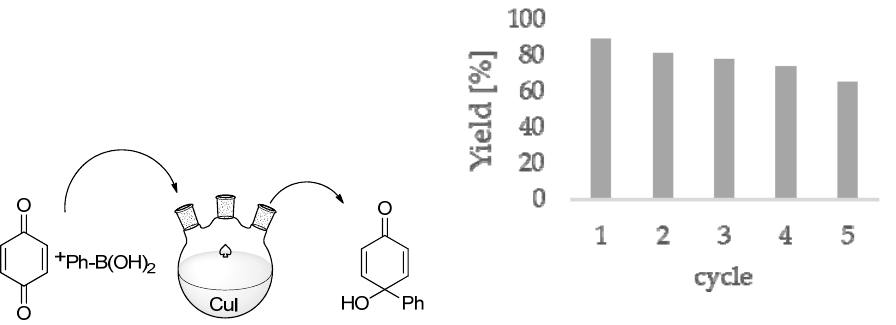
Figure 3. Reusability of CuI-PVP catalytic system in 1 synthesis. Phenylboronic acid (1 mmol), benzoquinone (1 mmol), CuI (0.1 mmol, 10 mol%), and PVP (10 mol%) in distilled water (4 mL) for 8 h, magnetic stirring 600 rpm, reaction shielded from light with aluminum foil.